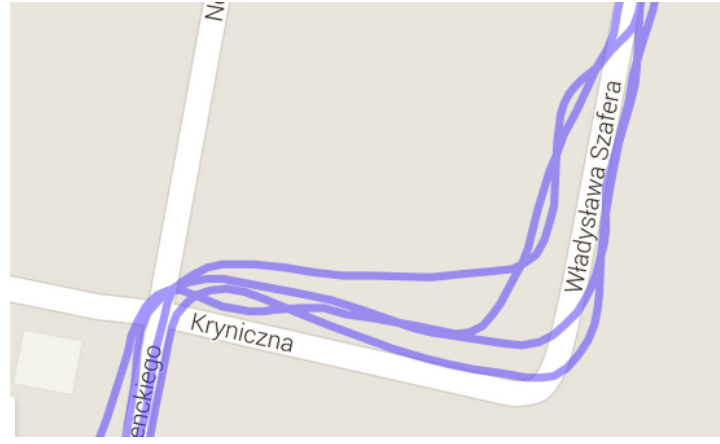
Figure 2. GNSS receiver inaccuracy–running the same route (Polar watch data).